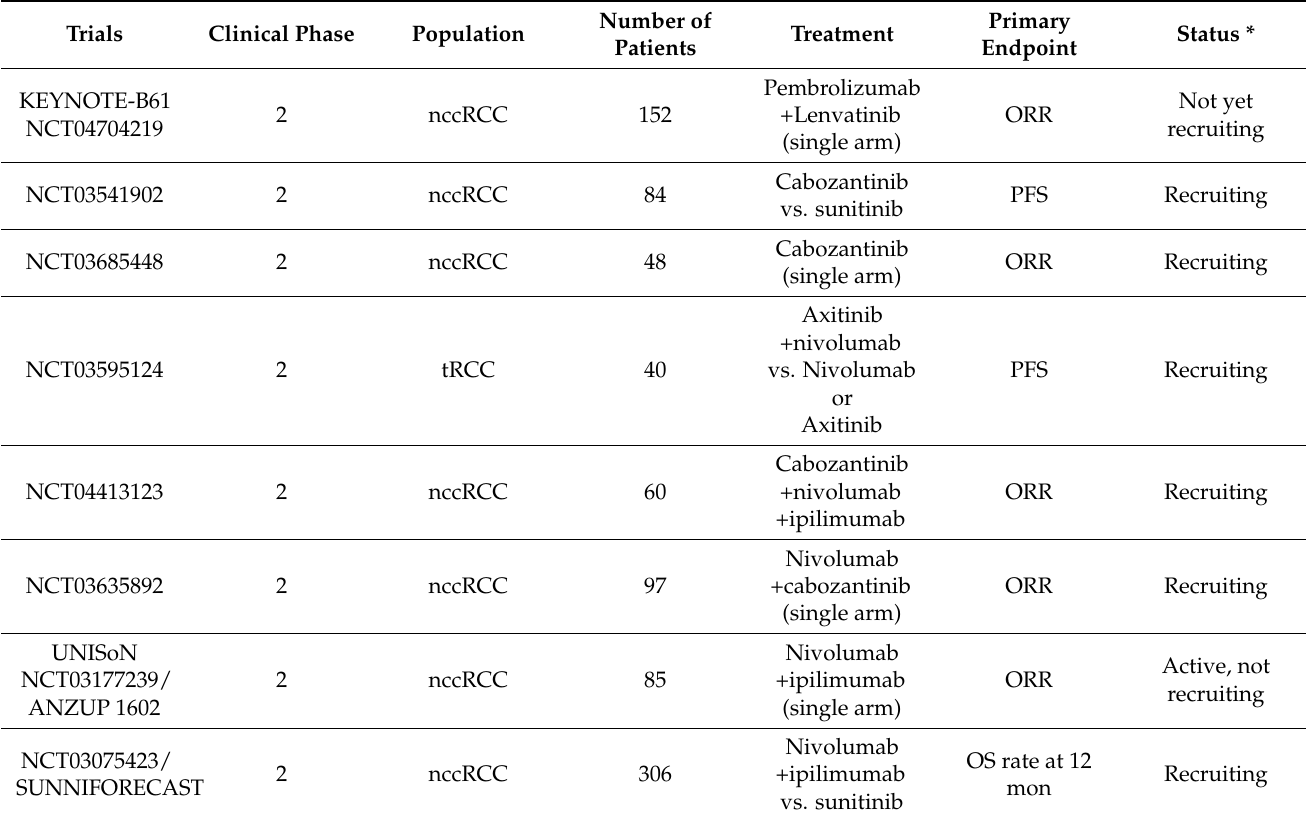
Table 5. Main ongoing clinical trials enrolling translocation renal cell carcinoma